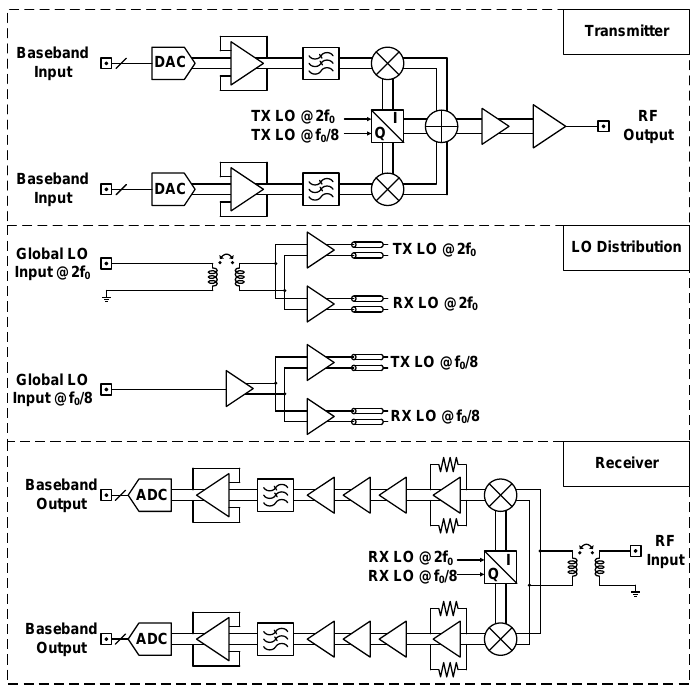
Figure 2. Simplified block diagram of the X-band CMOS